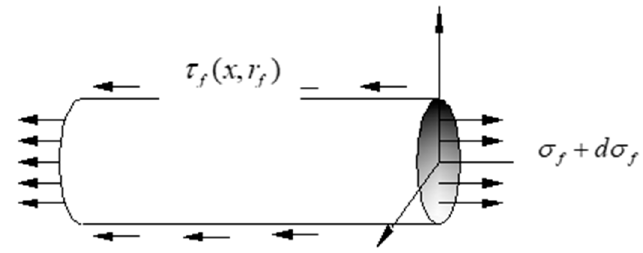
Figure 3. Mechanical mechanism diagram of adhesive layer micro unit.